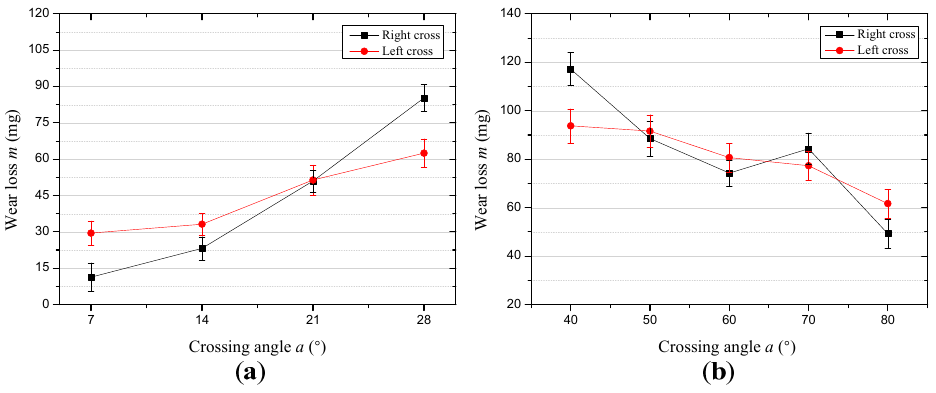
Figure 13. Wear mass loss for the different sliding conditions. ( a ) The wear mass loss for different cross directions in the case of a small crossing angle ( x : 10 mm; v : 6 mm/s) and ( b ) the wear mass loss for different cross directions in the case of a large crossing angle ( x : 20 mm; v : 12 mm/s).